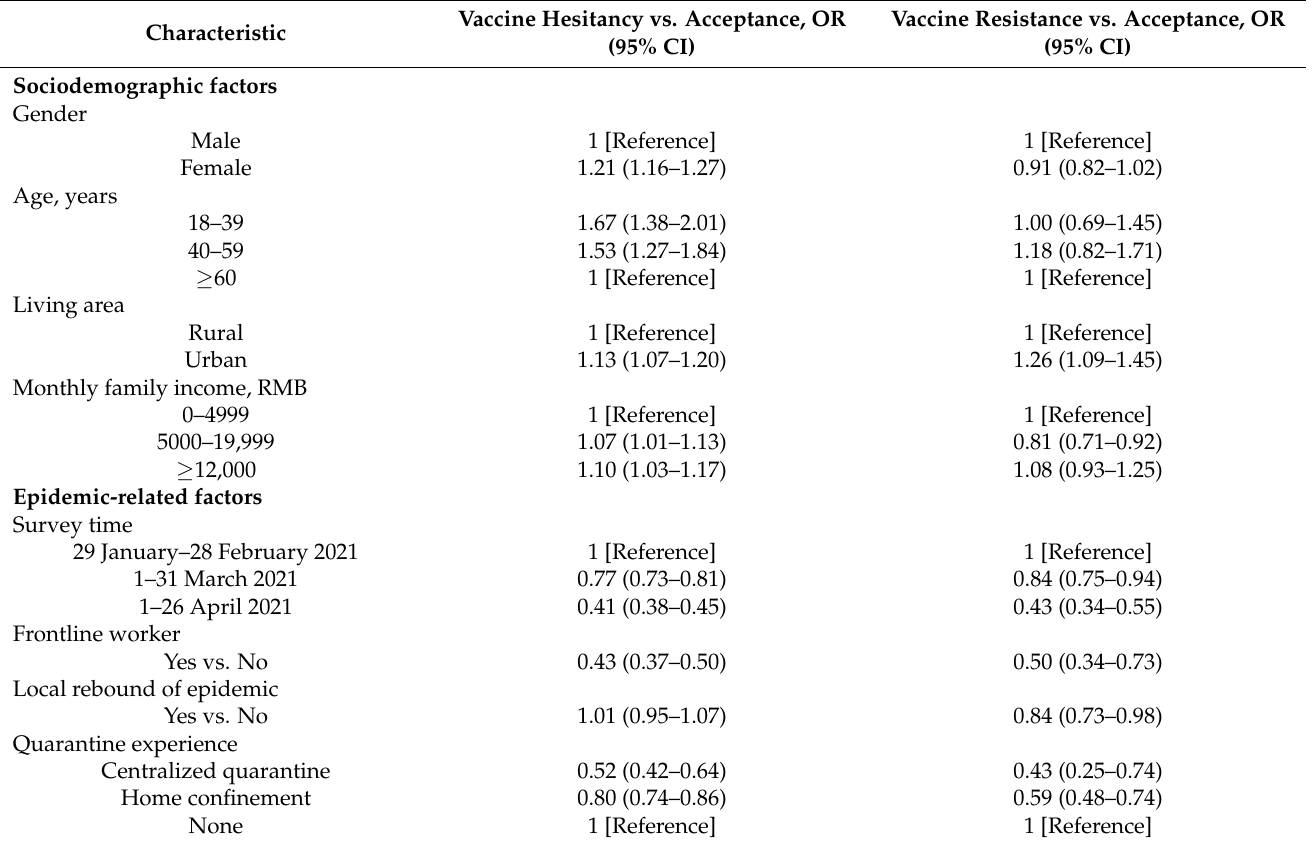
Table 3. Factors that influence vaccine hesitancy and vaccine resistance according to multinomial logistic regression.